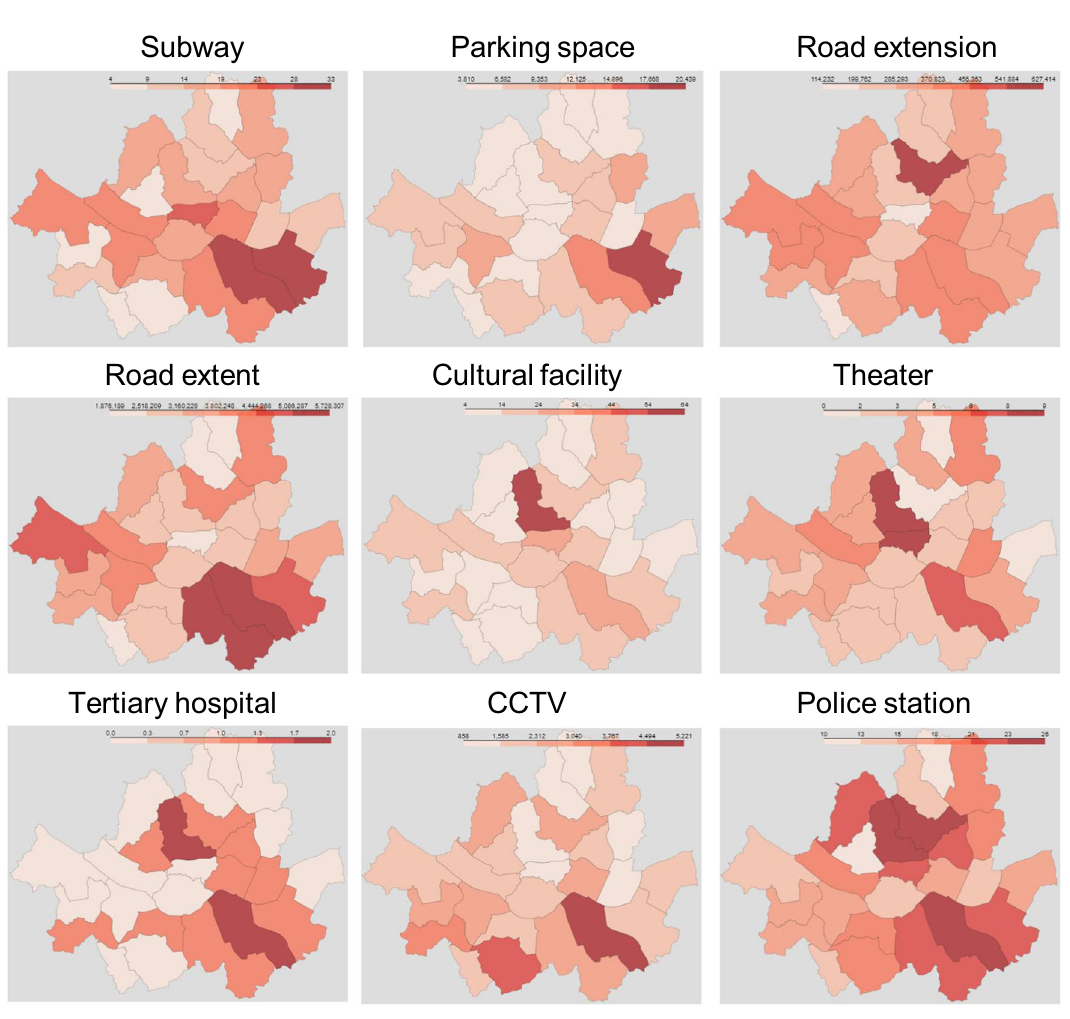
Fig. 3 Socio-spatial map of Seoul